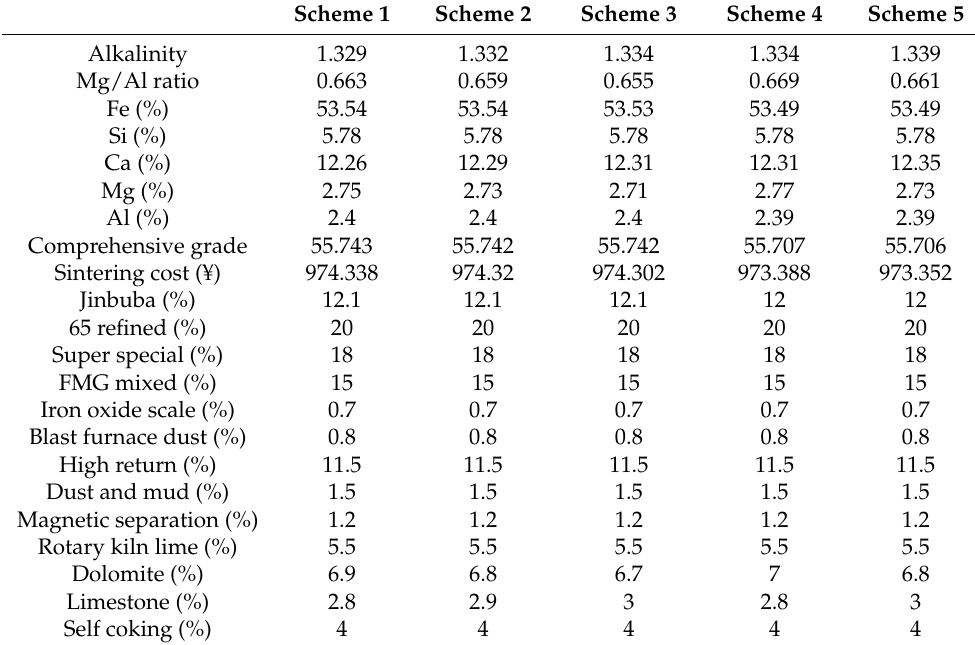
Table 7. Optimal sintering batching scheme aimed at reducing sintering